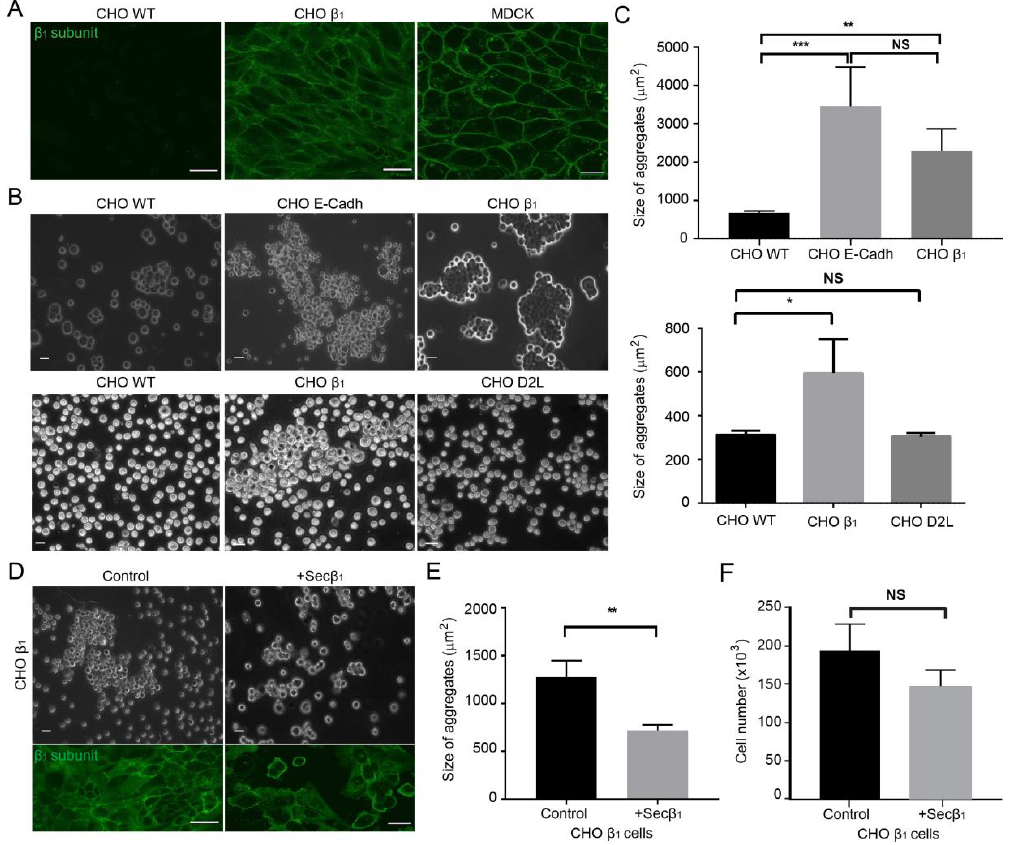
Figure 1. Cell-cell adhesion of CHO fibroblasts expressing the canine β 1 subunit of Na + ,K + -ATPase (CHO β 1 ) is mediated by β 1 - β 1 interactions. ( A ) Representative confocal microscopy images of CHO wild type, CHO β 1 and MDCK cells immunostained against the canine β 1 subunit. Scale bar = 30 µ m. ( B ) Representative light microscopy images of CHO wild type, CHO β 1 , CHO E-Cadherin, and CHO D2L cells after the dispase aggregation assay. Scale bar = 20 µ m. ( C ) Quantification of the size of the aggregates is depicted as the area of their horizontal projections. Values represent the mean from three independent biological replicates ± SE. Kruskal Wallis and Dunnet’s t-test for multiple comparisons were performed; NS, non-significant, * p < 0.05, ** p < 0.005, *** p < 0.0001. ( D ) Upper panels are representative phase-contrast micrographs of aggregation assays as in ( B ). Scale bar = 20 µ